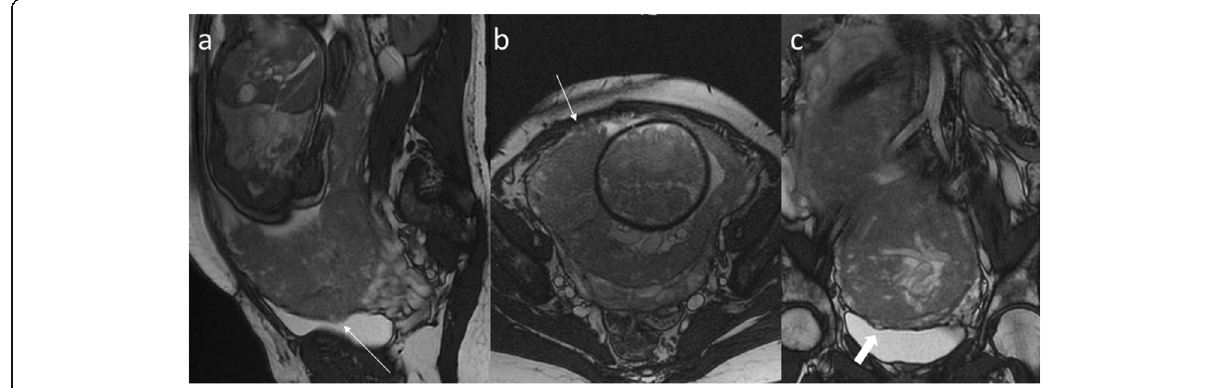
Fig. 16 The same woman as in Fig. 13. The lack of visibility of the fragment of the bladder wall (thin arrow, a ) and blurred placenta, uterus, and abdominal wall interface (thin arrow, b ) are highly suggestive of placenta percreta while the bulge indenting the bladder with preserved bladder wall most likely represents the varix (thick arrow, c